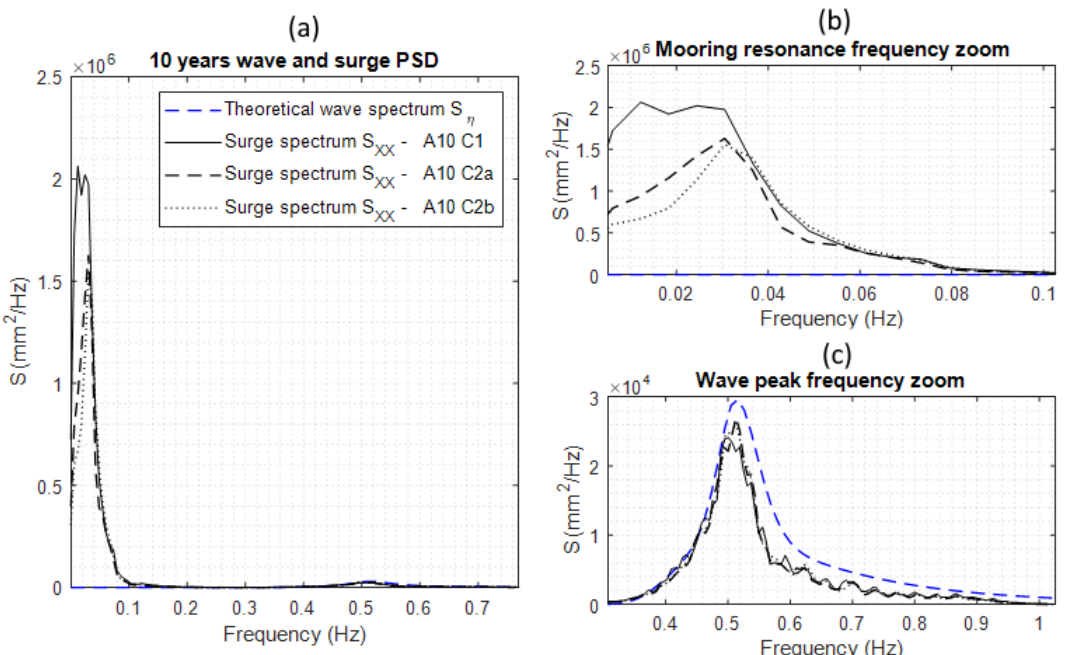
Figure 22. Surge motion and wave spectral density in ( a ), with zooms in ( b ) at the mooring resonance frequency, and in ( c ) around the wave peak frequency: 10-year